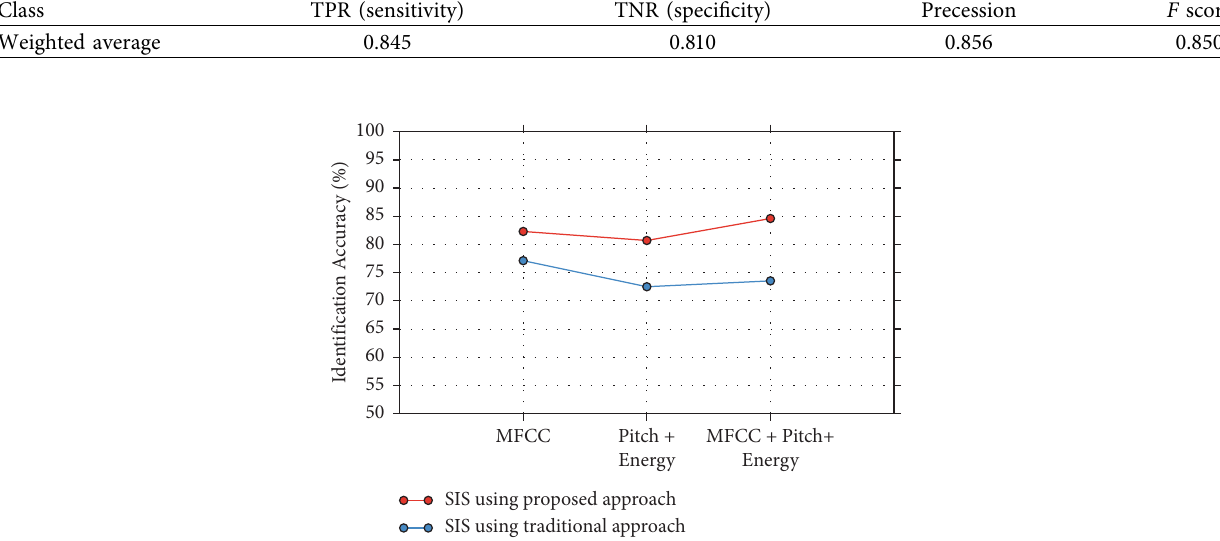
Figure 13: Identification performance of SIS with traditional approach vs SIS with proposed